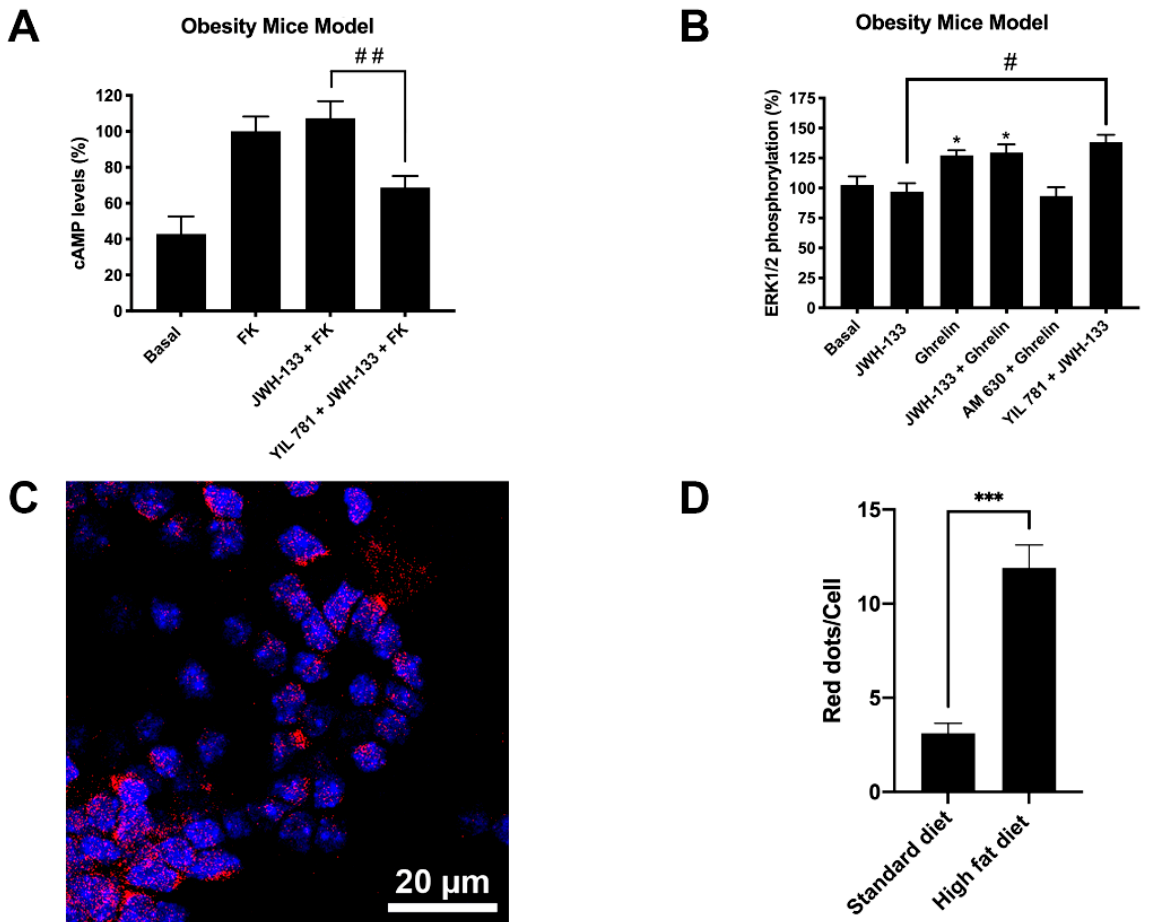
Figure 5. Expression and function of CB 2 R-GHSR1aHets in primary neurons isolated from fetuses of pregnant C57BL/6J female mice subjected to a high-fat diet. ( A , B ) Primary striatal neurons isolated from fetuses of pregnant females mice subjected to a high-fat diet for 60 days were pre-treated with antagonists, 1 µ M YIL 781 -for GHSR1a- or 1 µ M AM 630 -for CB 2 R-, followed by stimulation with selective agonists, 200 nM ghrelin -for GHSR1a- or 200 nM JWH-133 -for CB 2 R-, individually or in combination. cAMP levels were determined using the Lance Ultra cAMP kit and results were expressed in % versus 0.5 µ M forskolin treatment ( A ) while ERK1/2 phosphorylation was analyzed using the AlphaScreen ® SureFire ® kit (PerkinElmer) ( B ). Values are the mean ± SEM of 5 different experiments performed in triplicates. One-way ANOVA followed by Dunnett’s multiple comparison post-hoc test were used for statistical analysis. # p < 0.05, ## p < 0.005 versus JWH-133+FK treatment in cAMP or versus JWH-133 treatment in p-ERK1/2 assays. * p < 0.05, basal. ( C ). CB 2 R-GHSR1aHets were detected by the in situ proximity ligation assay (PLA) in primary striatal neurons; the negative control undertaken by omitting one of the primary antibodies is shown in Supplementary Figure S1. Experiments were performed in samples from 5 animals. The number of red dots/cell was quantified using the Andy’s algorithm Fiji’s plug-in and represented over cell stained nuclei with Hoechst (blue) ( D ). The number of dots-clusters/cell were compared to those in neurons from control mice (mice fed with standard diet). Unpaired t-test was used for statistics analysis. *** p < 0.001, versus control. Scale bar: 20 µ